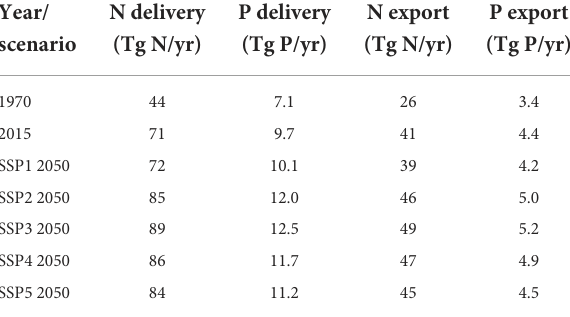
TABLE 1 Total global delivery and global export for N and P of the rivers for the years 1970 and 2015 and for 2050 for different SSP